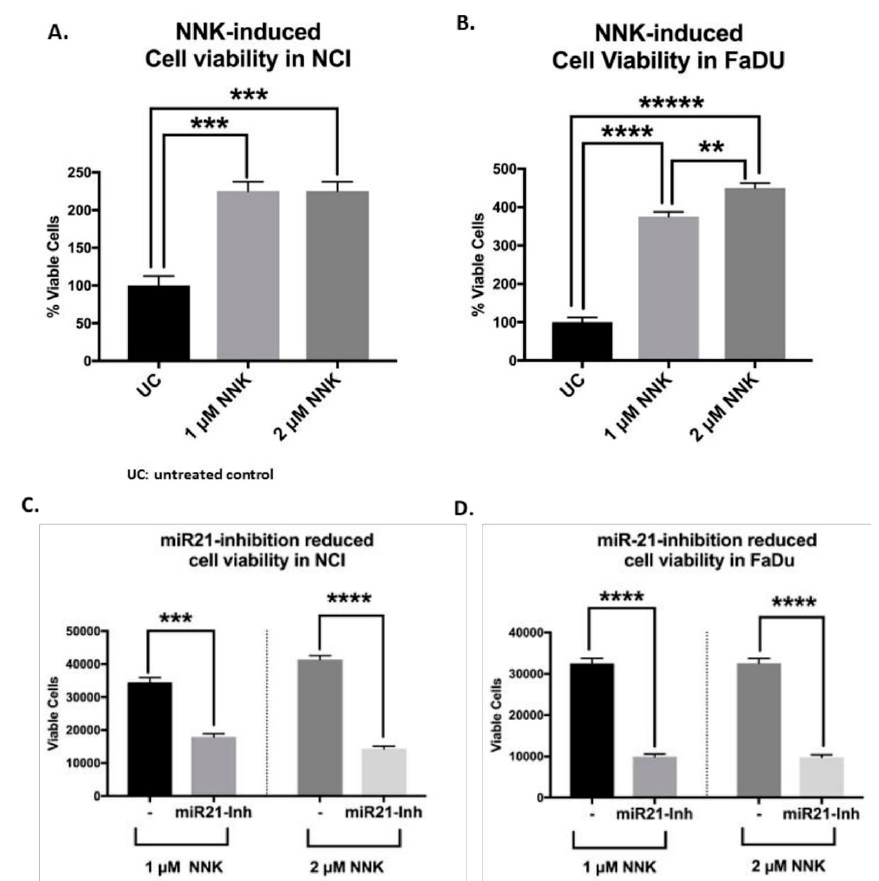
Figure 7. NNK promotes cell viability in lung (NCI) and head and neck (FaDu) squamous cancer cells, which is prevented by miR-21 inhibition. Graphs depict the viability rates in ( A ) NCI and ( B ) FaDu exposed to 1 µ M and 2 µ M of NNK (% of viable cells in NNK groups vs untreated controls) and the changes in the viability of ( C ) NCI and ( D ) FaDu cells under the inhibition of miR-21 (miR21-inh). Graphs, created by GraphPad Prism 7 software; ** p < 0.005; *** p < 0.0005; **** p < 0.00005; ***** p < 0.000005, by t -test; multiple comparisons by Holm-Sidak). (Data are derived from three independent experiments.).